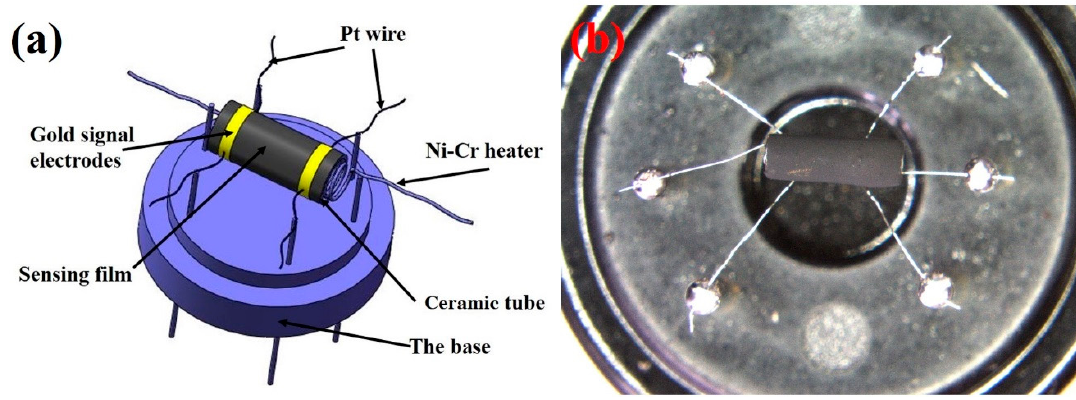
Figure 1. ( a ) Schematic illustration of the gas sensor and ( b ) photographs of the gas sensor.